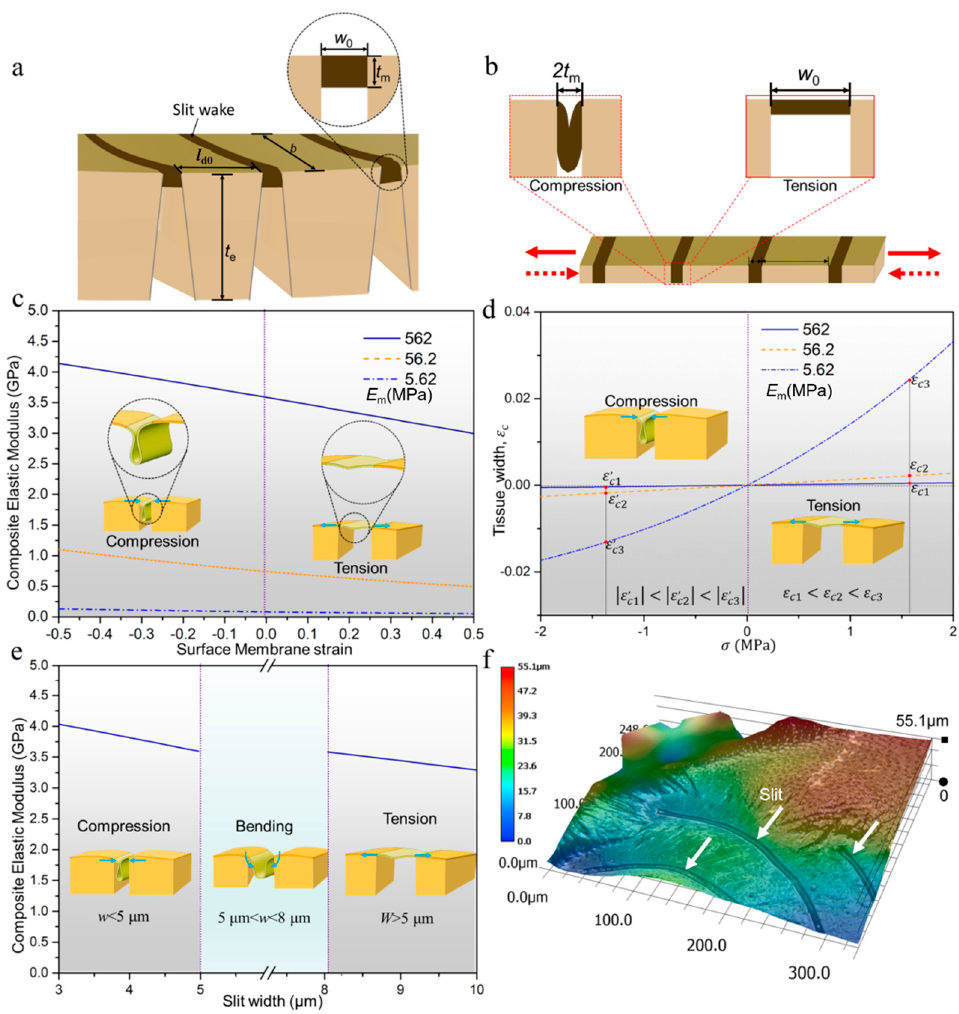
Figure 2. ( a ) Structural model of tissue around a slit wake; ( b ) simplified structural model based on ( a ) for analyzing the process of tension and compression; ( c ) the composite elastic modulus as a function of membrane strain under di ff erent values of Em ; ( d ) the relationship between the strain of composite tissue and applied stress under di ff erent values of Em ; ( e ) the deformation type of surface membrane in di ff erent range of slit width; ( f ) three-dimensional surface morphology of tissue around a slit wake.